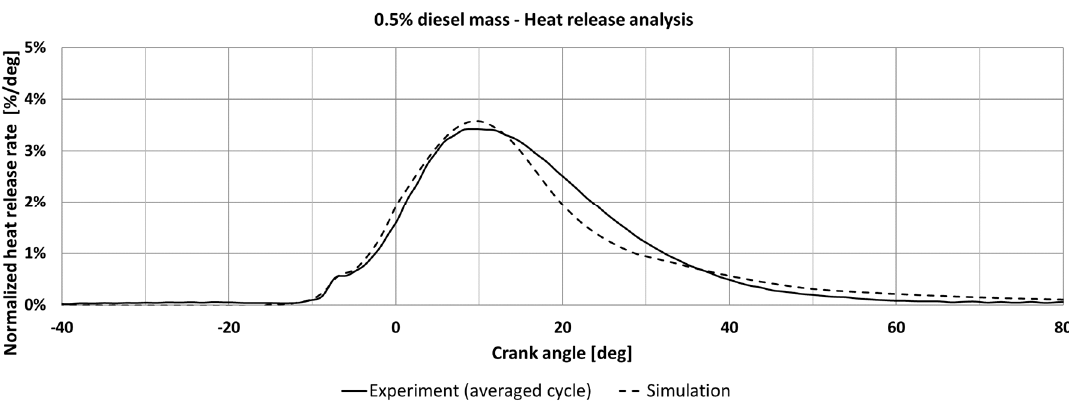
Figure 18. Measured and simulated heat release rates, 0.5% diesel mass injected.